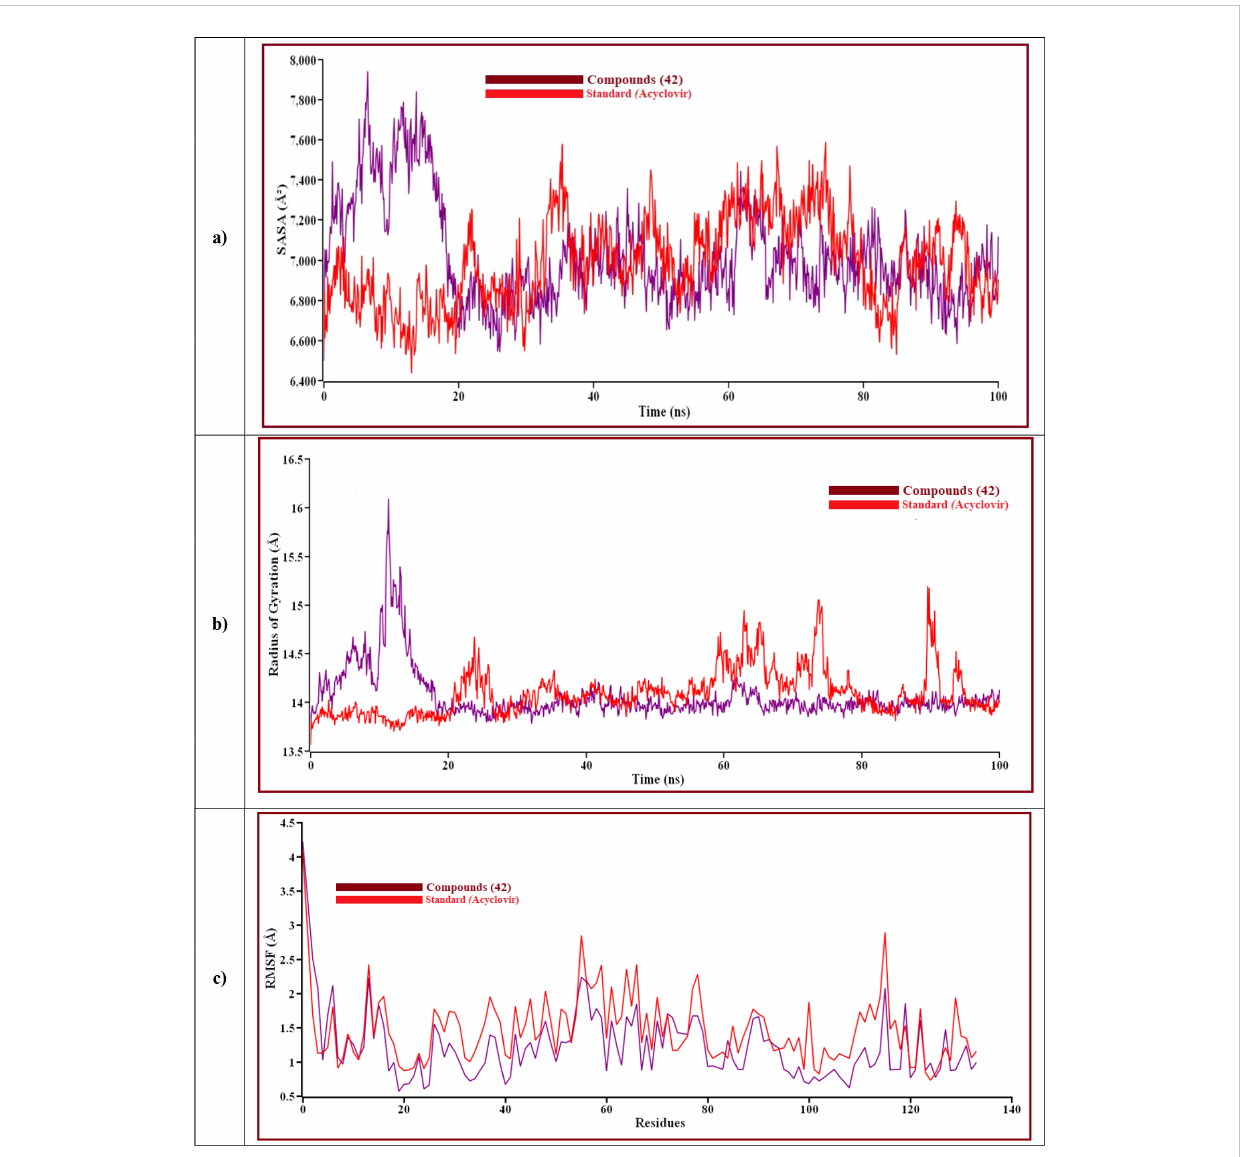
FIGURE 10 The structural behavior change of protein by means of (A) solvent accessible surface area (SASA), (B) radius of gyration, and (C) root means square fl uctuations (RMSF) analysis. Here, the red line indicates Acyclovir, and the violet line indicates compound 42 complexes, respectively.